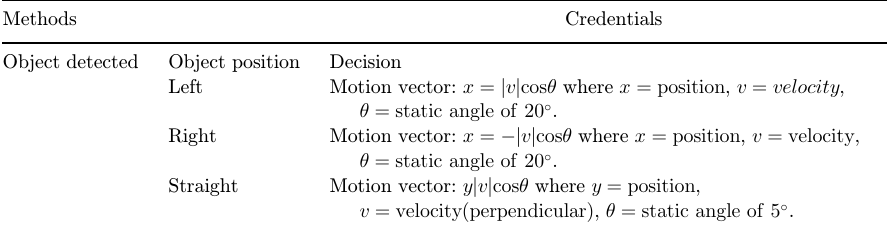
Table 2. Motion vector credentials.